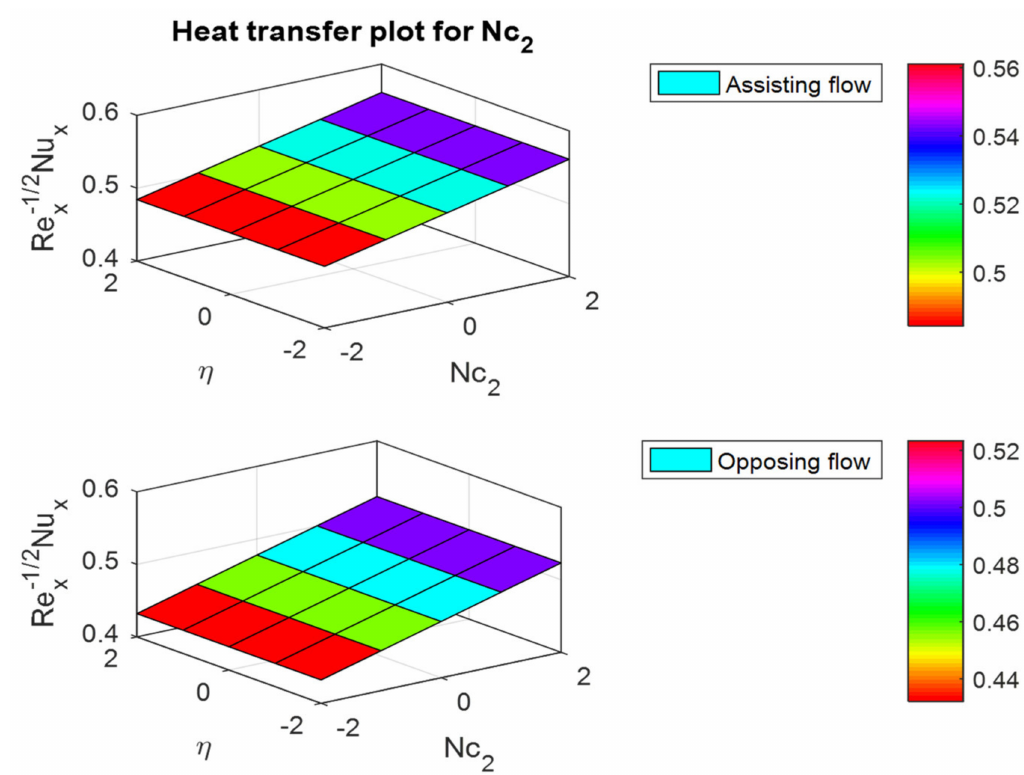
Figure 35. Surface plots for the θ (cid:48) ( 0 ) for dissimilar values of Nc 2